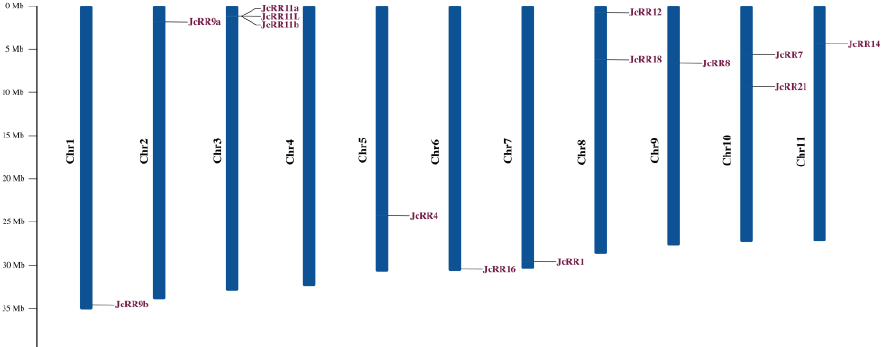
Figure 5. Locations and duplications of putative RRs on J. curcas chromosomes. Shown is the distribution of RR genes across the chromosomes of J. curcas plants. The genetic distance of seven chromosomes is represented by the scale in megabases (Mb) on the left. The JcRRs are displayed on the basis of the nomenclature used for the high-quality reference genome of J. curcas . The black lines represent the location of the genes on each chromosome.